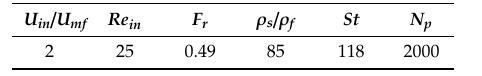
Table 2. Simulation parameters for gas–solid flows.